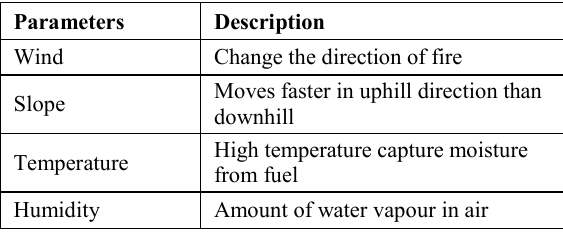
Table 1. Parameters affecting the forest